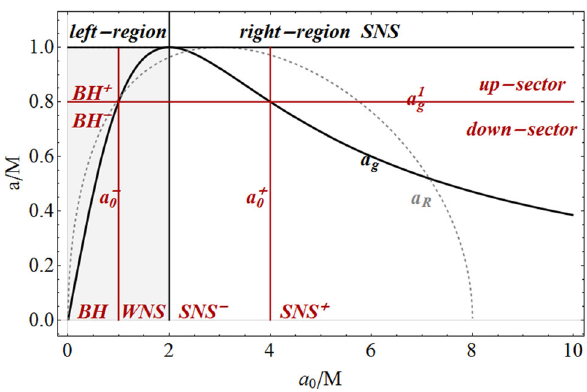
Fig. 13 Plots of the spins a g and a R defined in Eq. (17) as functions of the origin a 0 / M . BH and NS regions are gray shaded. a g is a represen- tation of the BHs – NSs correspondence – see also Fig. 12. The sectors andregionscorrespondingtostrongnakedsingularities( SNS )andweak naked singularities ( WNS ) are explicitly shown (cf. definitions given in = M , a + = 4 M : a = a + = ( 3 / 4 ) M = a ( a − 1 Sect. 4). Here a − g g g , a g 0 0 0